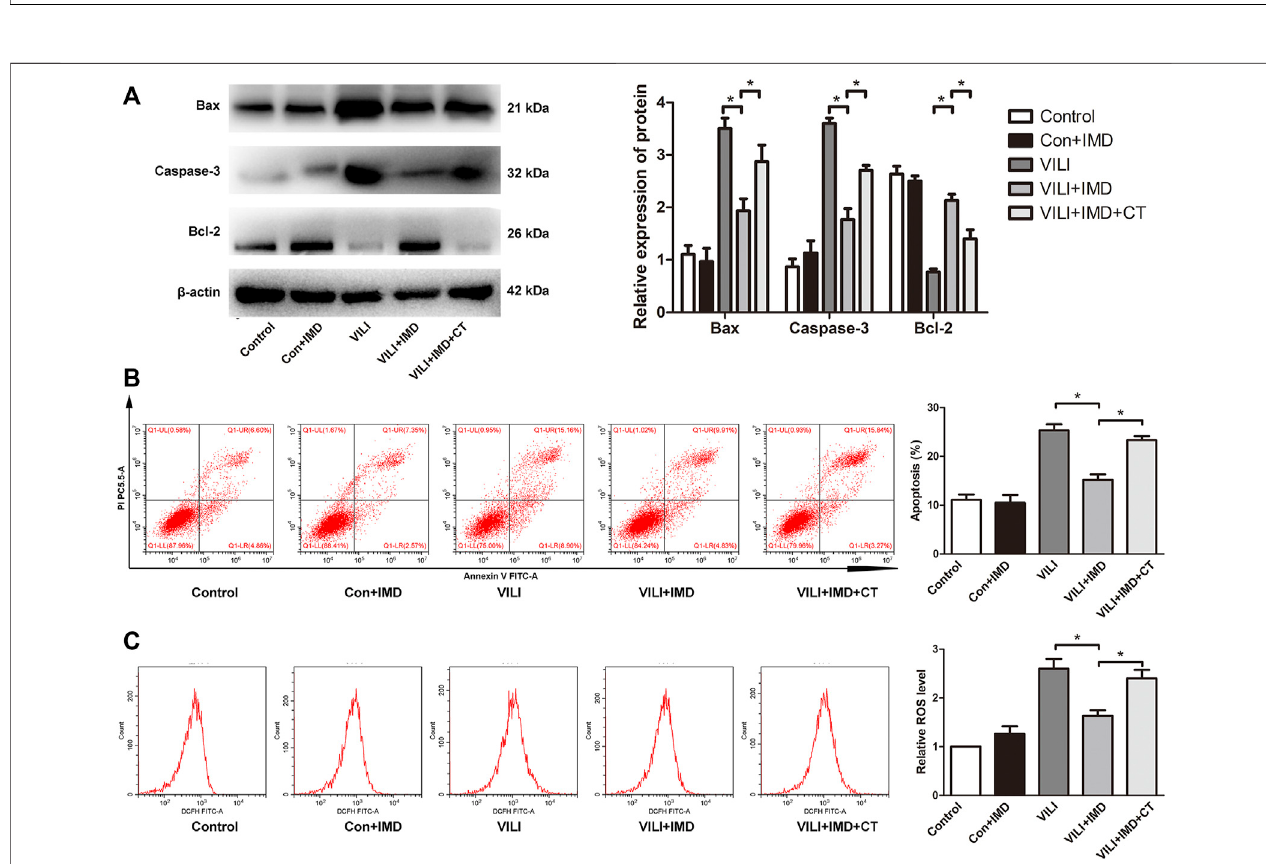
FIGURE 5 | JAK2/STAT3 pathway was involved in IMD-mediated protection. (A) Western blot analysis of p-JAK2, JAK2, p-STAT3, STAT3 and β -actin in lung tissues. (B) Cell apoptosis rate was detected using fl ow cytometry. (C) Cell ROS was detected using fl ow cytometry. * p < 0.05.